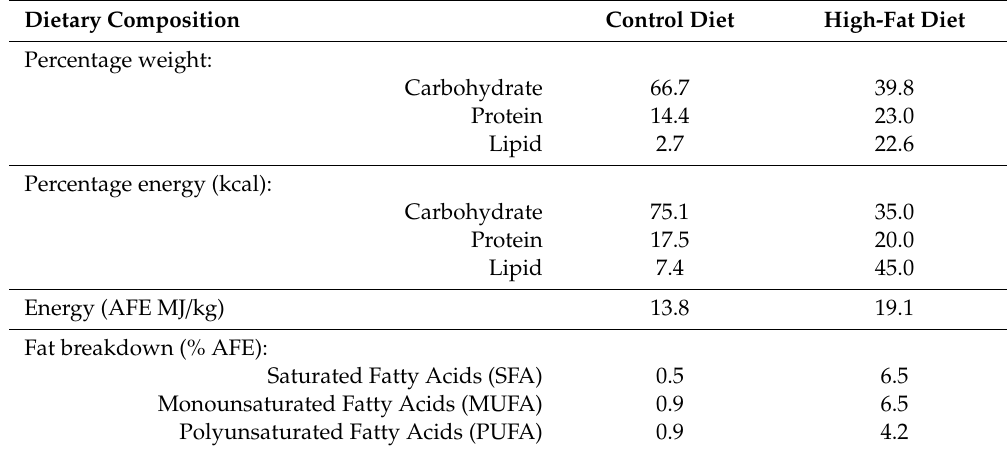
Table A1. The dietary composition of macronutrients and energy values of the diets used in this study. Dietary Composition Control